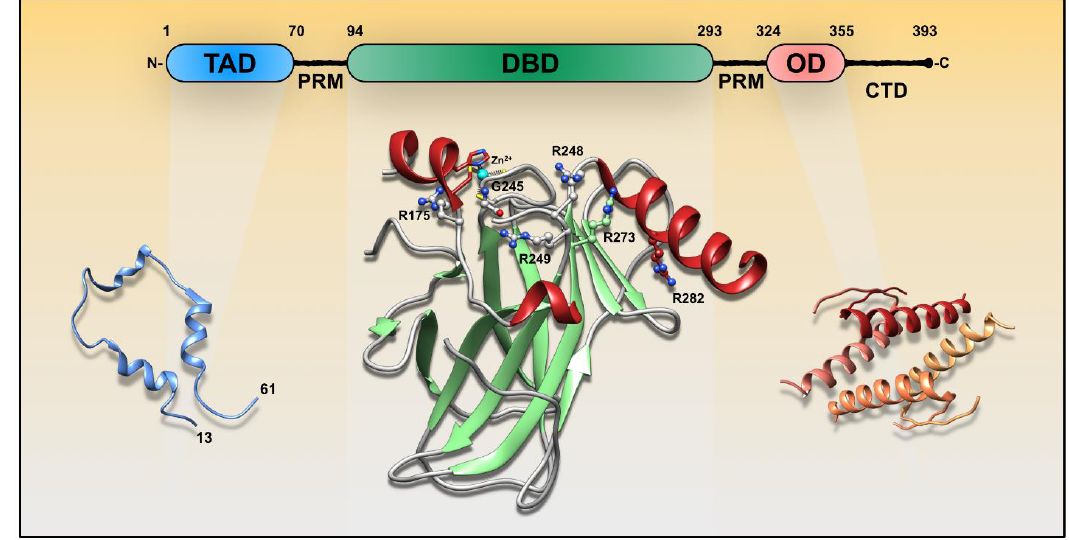
Figure 1. Structure organization of p53 and hotspot mutated sites in cancer. TAD, transactivation domain; PRM, proline-rich motif; DBD, DNA-binding domain; OD, oligomerization domain; CTD, C-terminal domain. (PDB codes: TAD-2L14; DBD-2FEJ; OD-1OLG).